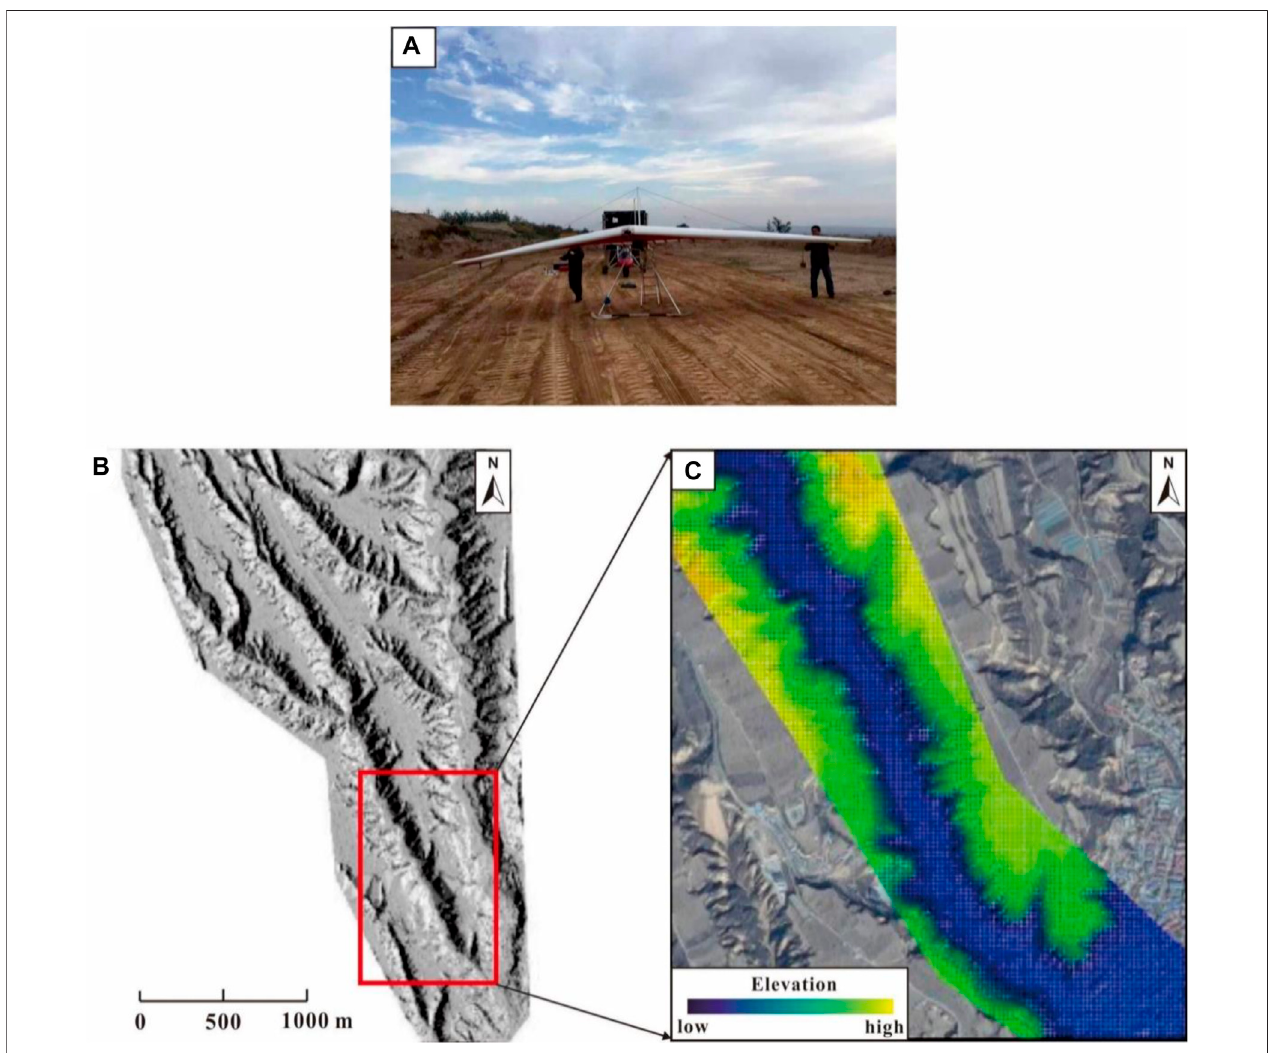
FIGURE4| TopographydataoftheChengbeiGullyregion: (A) themannedairborneLiDARusedinthisstudy, (B) hillshademapcalculatedusing1 mDEM,and (C) elevation map of the zoomed area, with the remote sensing images as the base map.